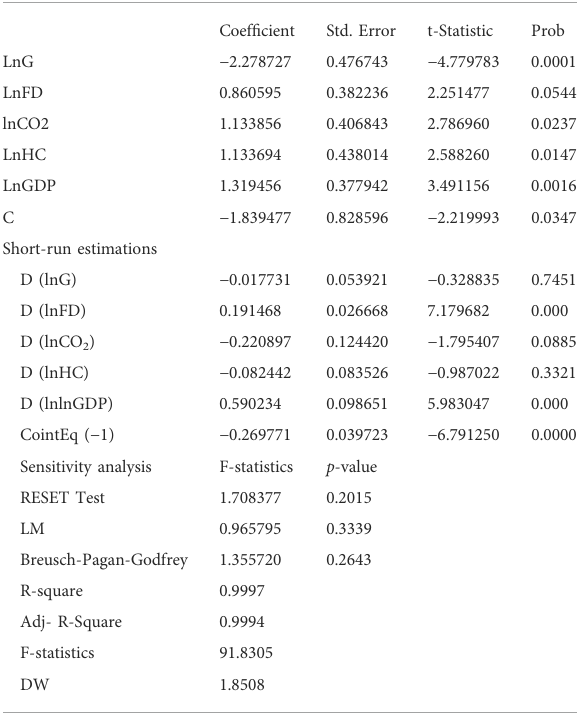
TABLE 8 Long and Short Runs Estimations Dependent variable = Renewable Energy. Long-run estimations lag order (1, 1, 0, 0,1,